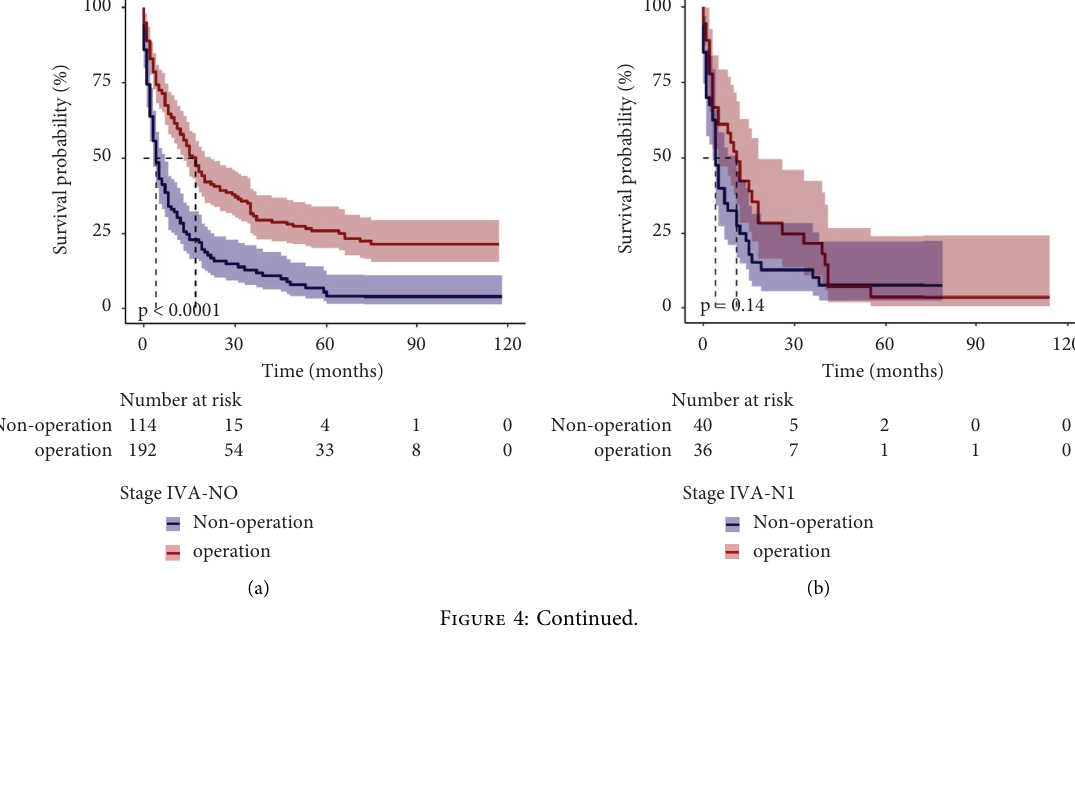
Figure 3: Kaplan − Meier plots for overall survival. (a) Stage IIIA-N0; (b) stage IIIA-N1; (c) stage IIIA-N2.